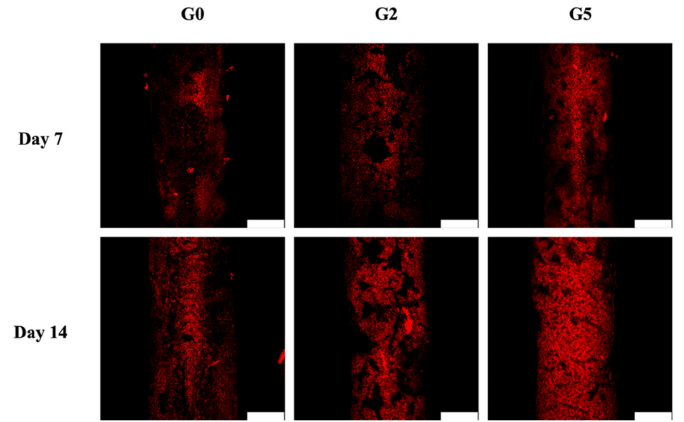
Figure 9. Alizarin Red S staining of hDPSCs calcium mineral deposits cultured on the GR-contained MSCS scaffolds for 7 and 14 days. The scale bar is 200 µ